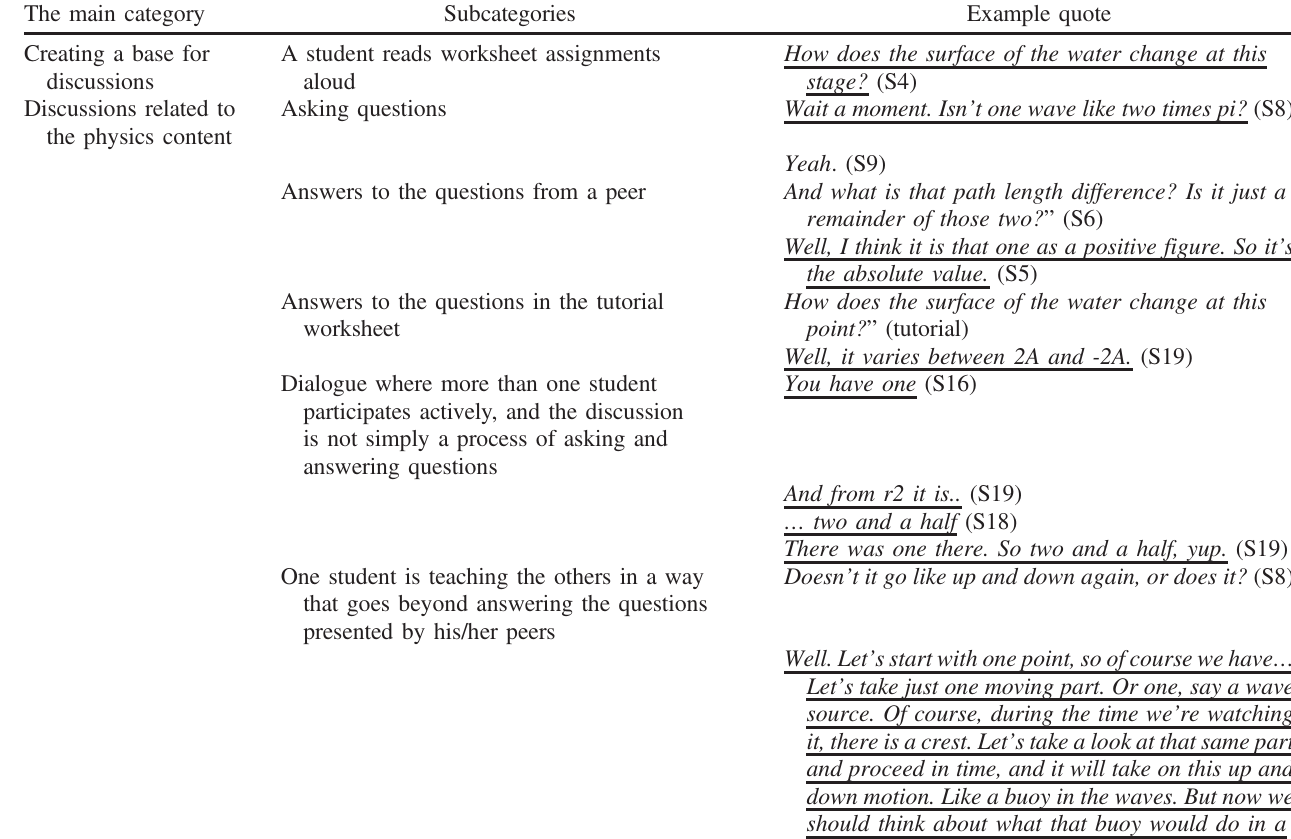
TABLE II. A substructure of the four main categories observed in students ’ discussions. Sample quotes for the subcategories are included. Each line placed in a given category has been underlined; the surrounding text extracts are included discretionally to illustrate the context of the particular discussion. The symbols in parentheses after the quotation refer to the individual students (S1 –